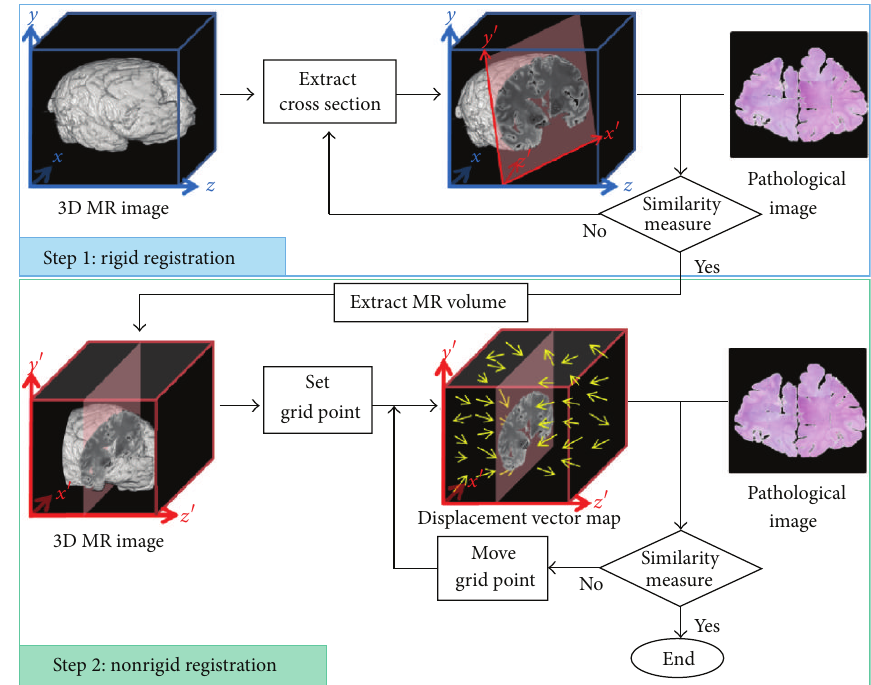
Figure 1: Flow of method.